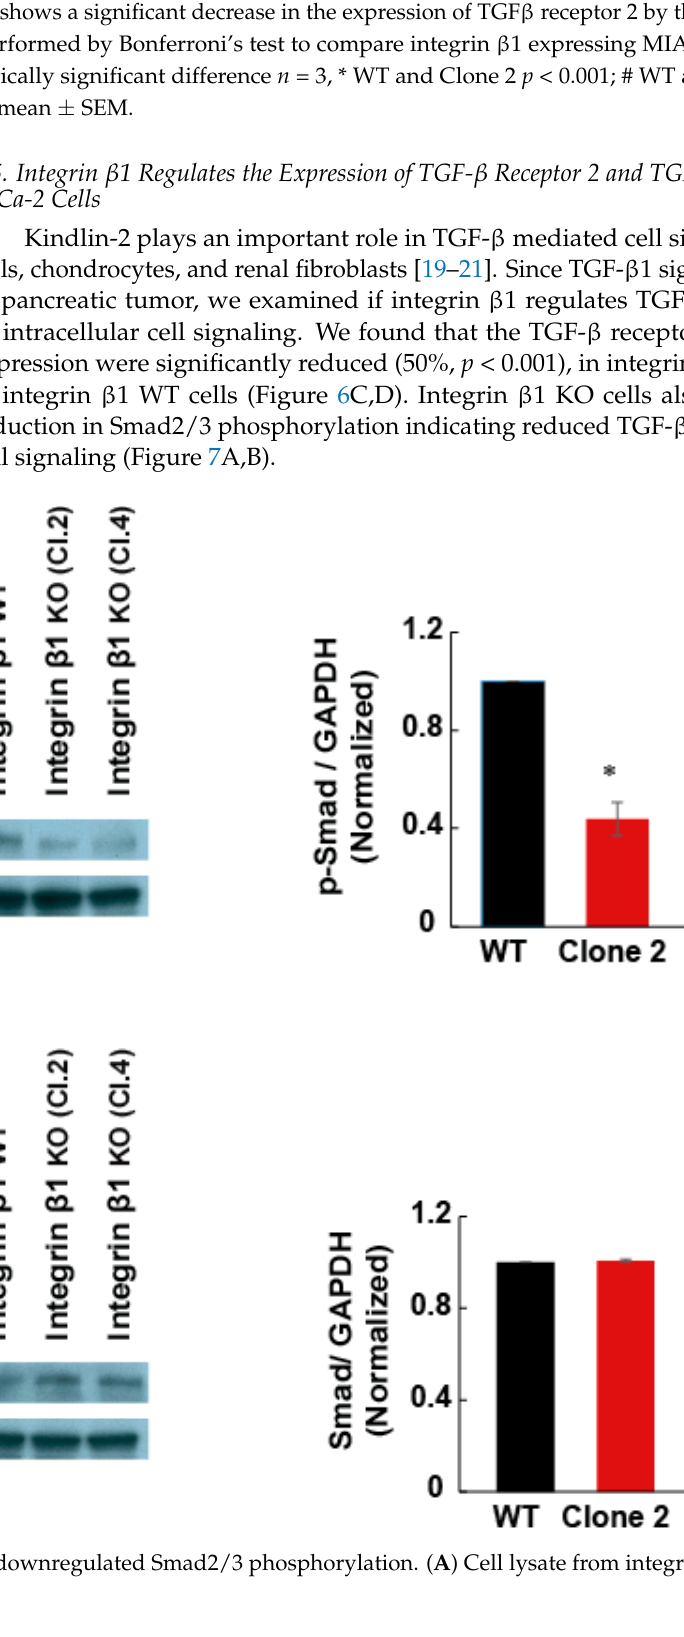
Figure 6. Integrin β 1 deletion downregulated Kindlin-2 and TGF β receptor 2 expression. ( A ) Cell lysate (30 µg/lane) from integrin β 1 expressing MIA PaCa-2 and integrin β 1 KO clones are immunoblotted for kindlin-2. Normalized protein ex- pression with GAPDH shows a decrease in kindlin-2 expression in clones compared to the normal MIA PaCa-2 cells. ( B ) The mRNA expression quantified by RT-PCR analysis shows a significant decrease in the expression of kindlin-2 by the deletion of integrin β 1. ( C ) Lysates were immune blotted with antibody recognizing TGF β receptor 2. GAPDH is used as the loading control. Normalized protein expression shows downregulation of TGF β receptor 2. ( D ) The mRNA expression